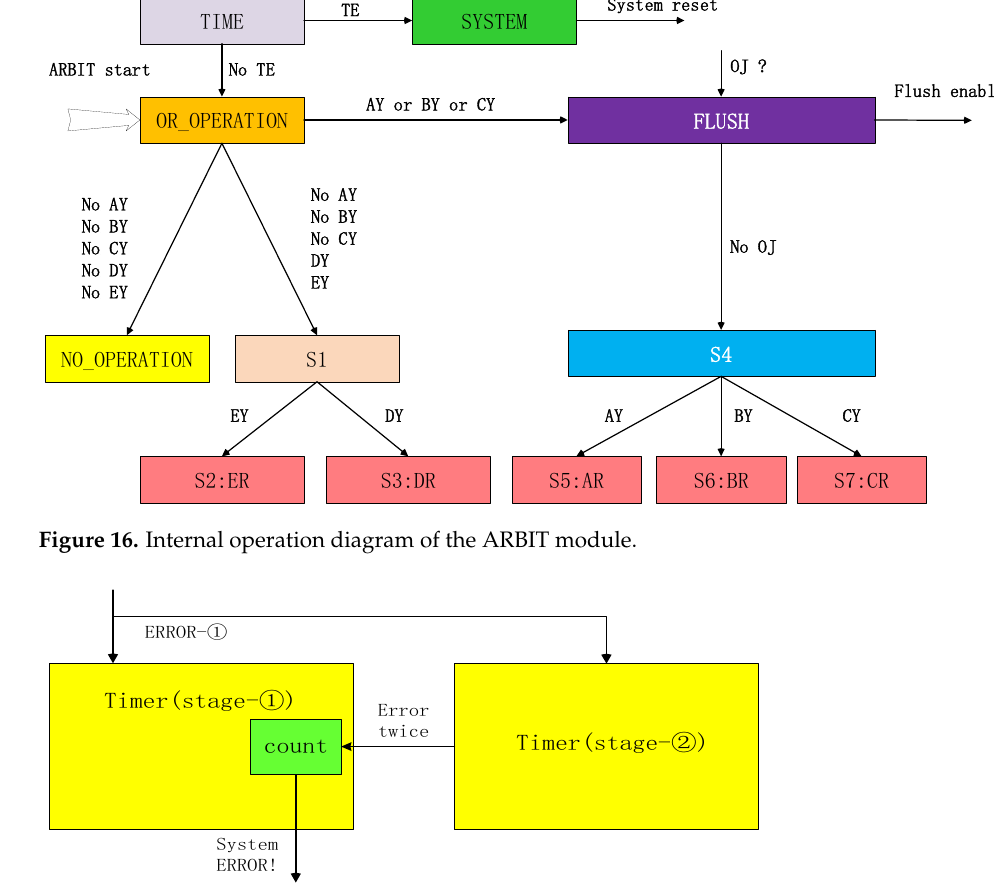
Figure 17. Fatal error abnormal monitoring. The module is embedded between 1 to 5 stages of the pipeline and is placed at every two stages of the pipeline to monitor whether the errors between two adjacent decoding modules occur repeatedly. If the interval period is one cycle, the count will increase by 1, and a fatal information alarm will be sent after the count reaches the threshold. Then, the system generates a system ERROR.